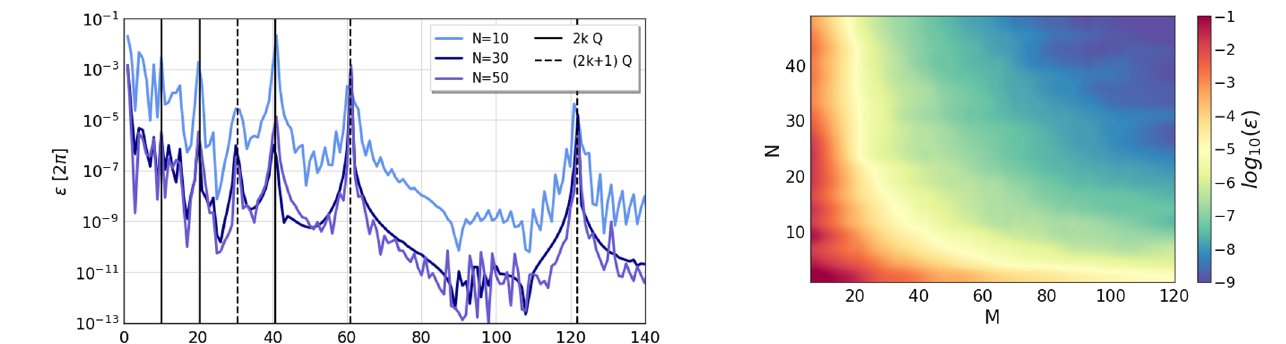
FIG. 6. Color map of the tune estimation error with the mixed BPM method for a numerical simulation with P y NAFF . Accurate values of the tune, at the order of 10 − 5 , can be achieved with either a small number of turns ( N ≤ 10 ) or a larger number of BPMs ( M ≥ 50 ). The same conclusions can be made for N ≥ 40 and M ≤ 30